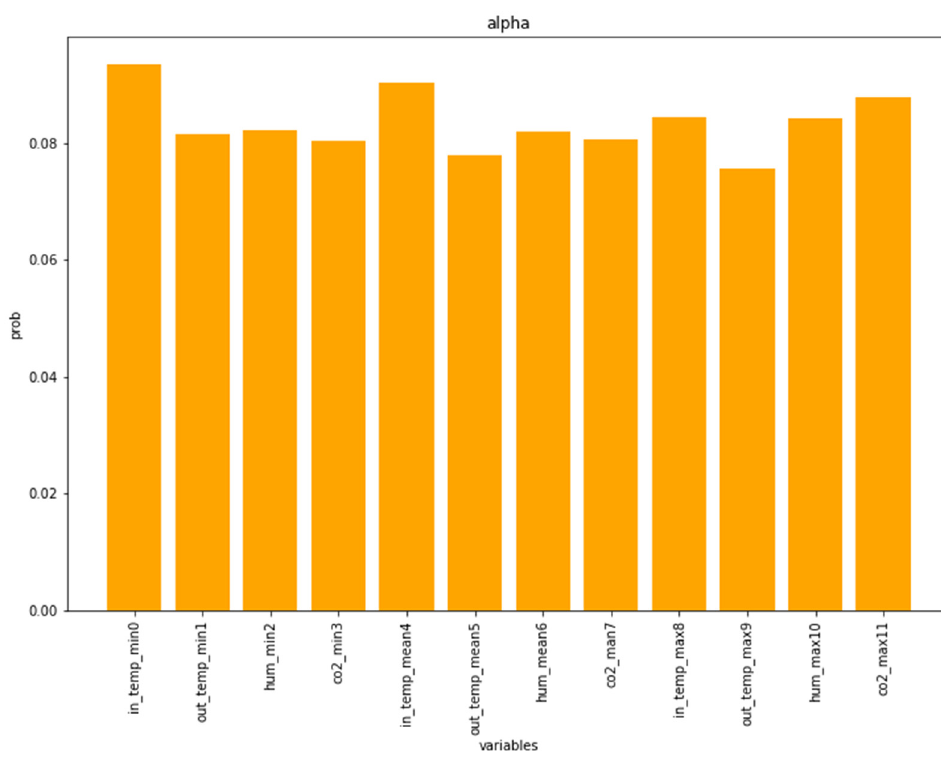
Figure 4. Attention weights for input environmental variables.